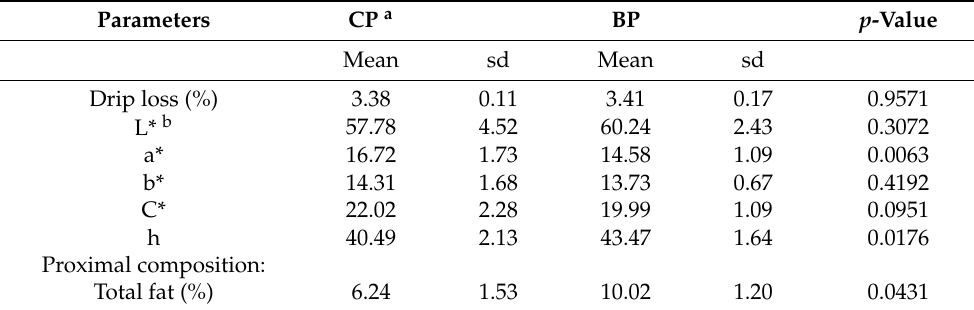
Table 3. Effect of breeds on the meat quality of pork ( longissimus dorsi